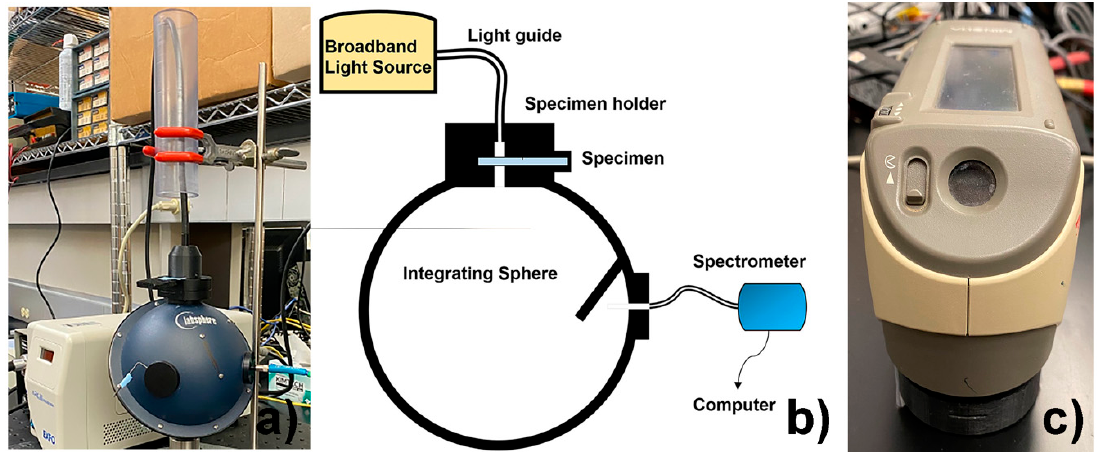
Figure 2. ( a ) Spectrometer/Integrating sphere system for the evaluation of percent light transmittance. ( b ) Diagram of light transmittance measurement system. ( c ) Spectrophotometer (CM-2600d Spectrophotometer, Konica Minolta, Tokyo, Japan) for color parameter change.